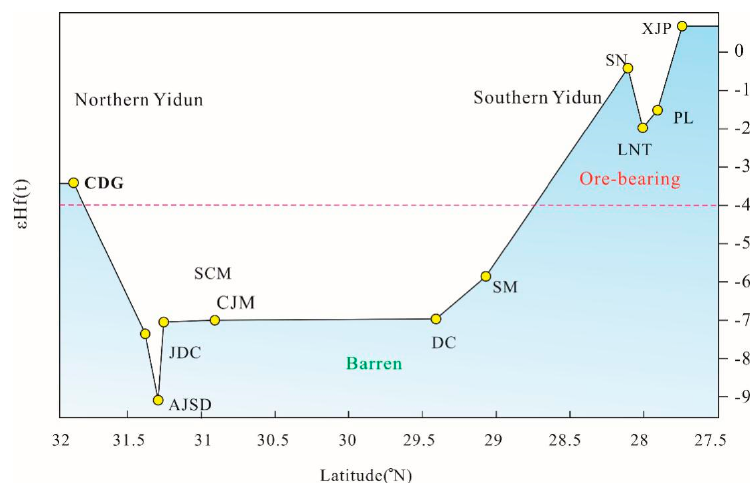
Figure 9. Diagram of ε Hf( t ) vs. latitude to illustrate the contribution of mantle components for the ore-fertile granites from north to south in the Yidun arc. The data are from refs. [4,6]. Abbreviations: